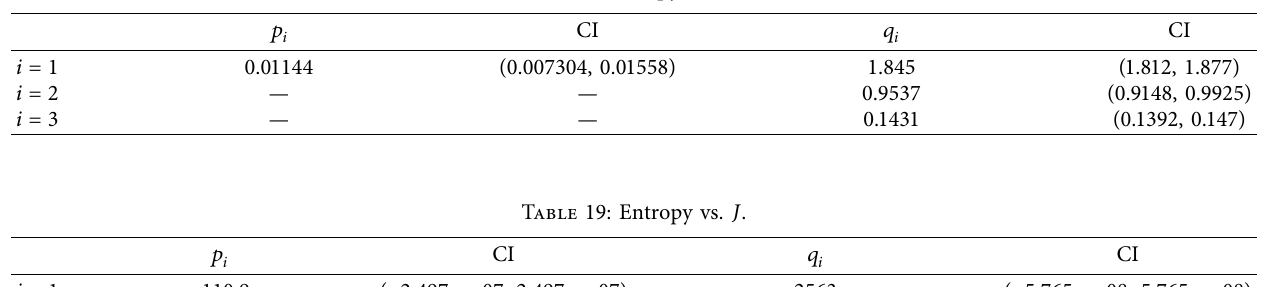
Table 18: Entropy vs. AZI.